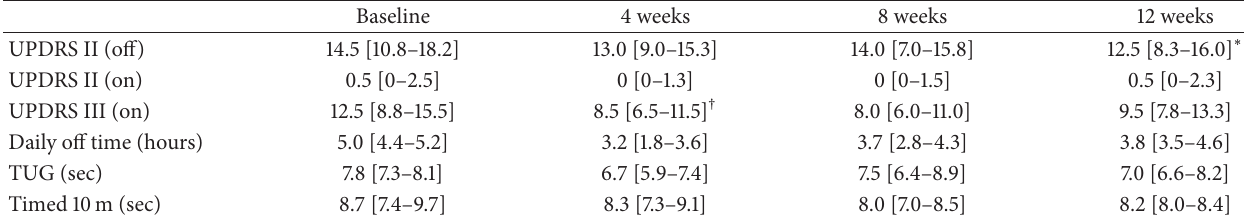
Table 2: Outcome measures from baseline to 12